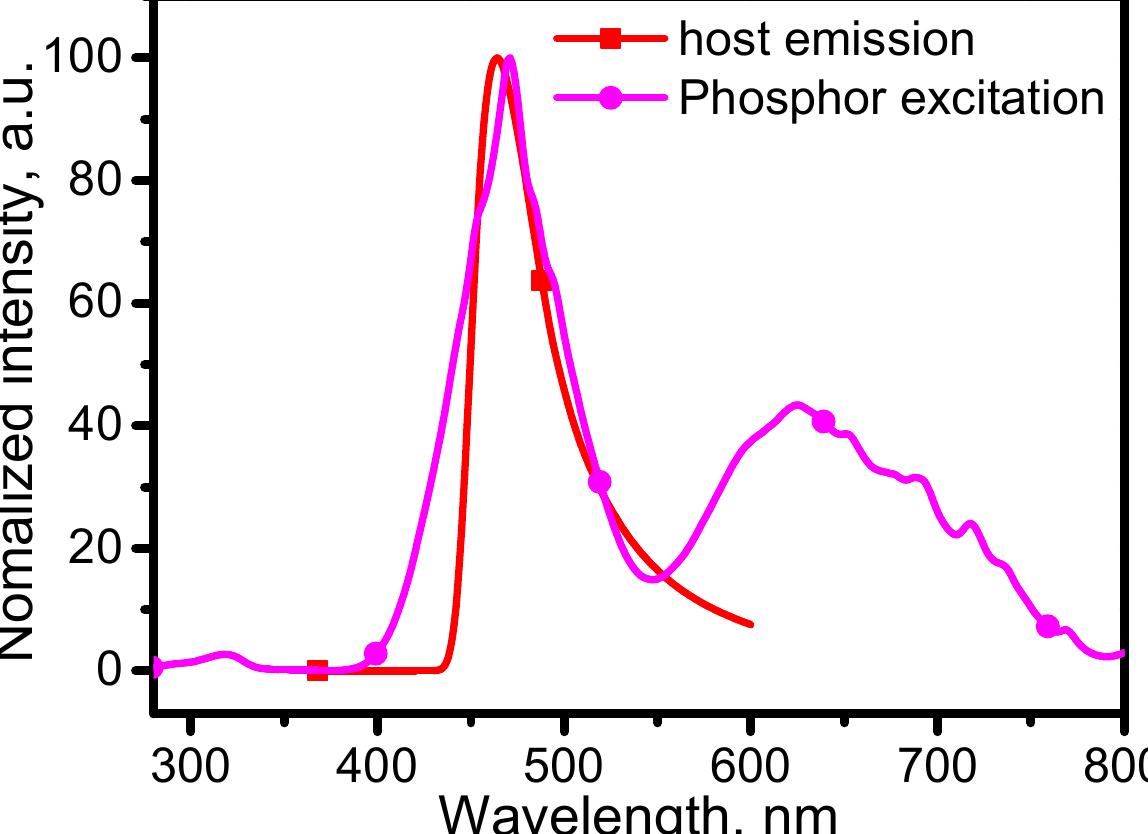
Figure 7. The excitation spectrum of CeSc 3 (BO 3 ) 4 :Cr 3+ phosphor and the emission of CeSc 3 (BO 3 ) 4 host by plotting them together.